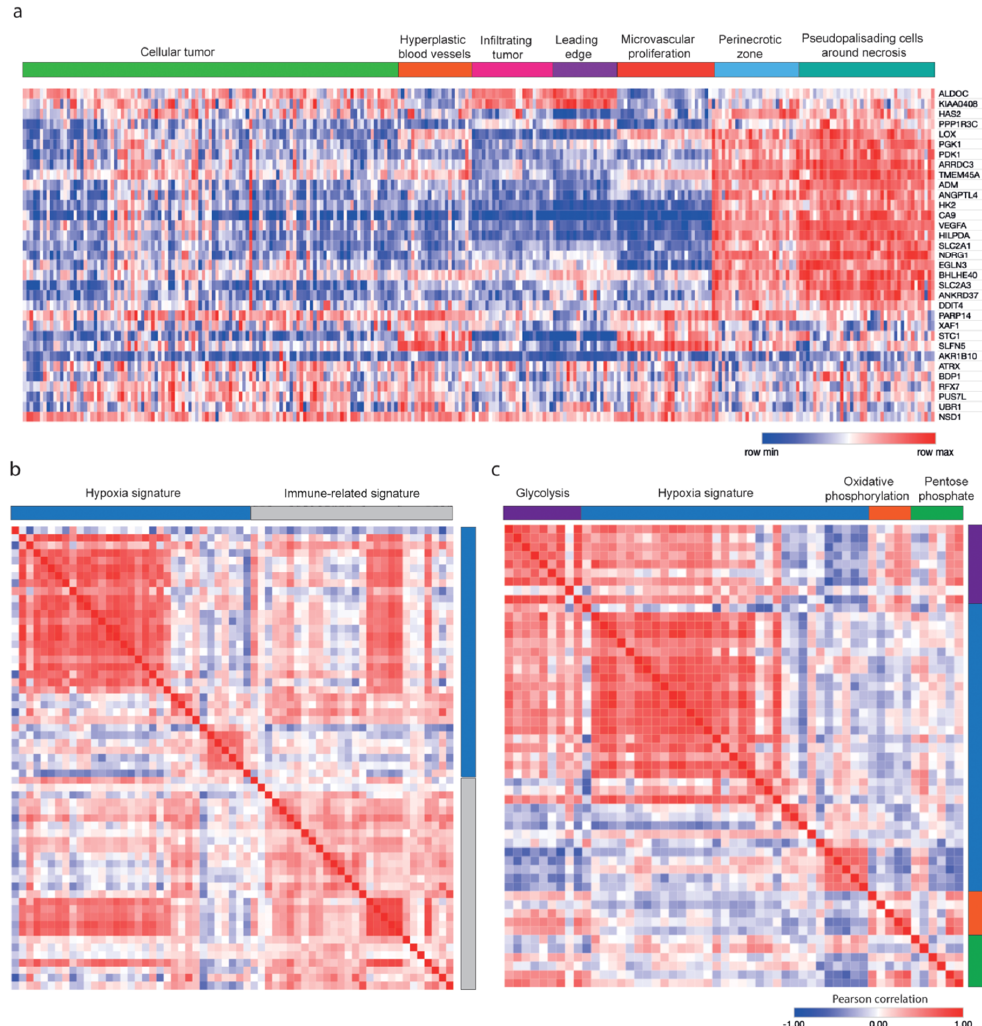
Figure 2. Expression and correlation of the hypoxia gene signature using the Ivy-GAP database. ( a ) Expression of the hypoxia gene signature in different areas of human GBM ( n = 270) biopsies; ( b , c ) Correlation matrix of the hypoxia signature with ( b ) immune-related genes or ( c ) three metabolic pathways gene lists. List of immune-related genes (from left to right and top to bottom): ARG2, ARG1, TGFB1, IDO1, IL10, CD163, MRC1, CCR4, CCR7, CD80, CD3G, CD3D, CD3E, GZMB, PRF1, CD86, IL1A, IL6, IL1B, IL8, CCL20, TNF, IFNG, IL2, ICAM1, ITGAL, ITGA4, ITGB2.